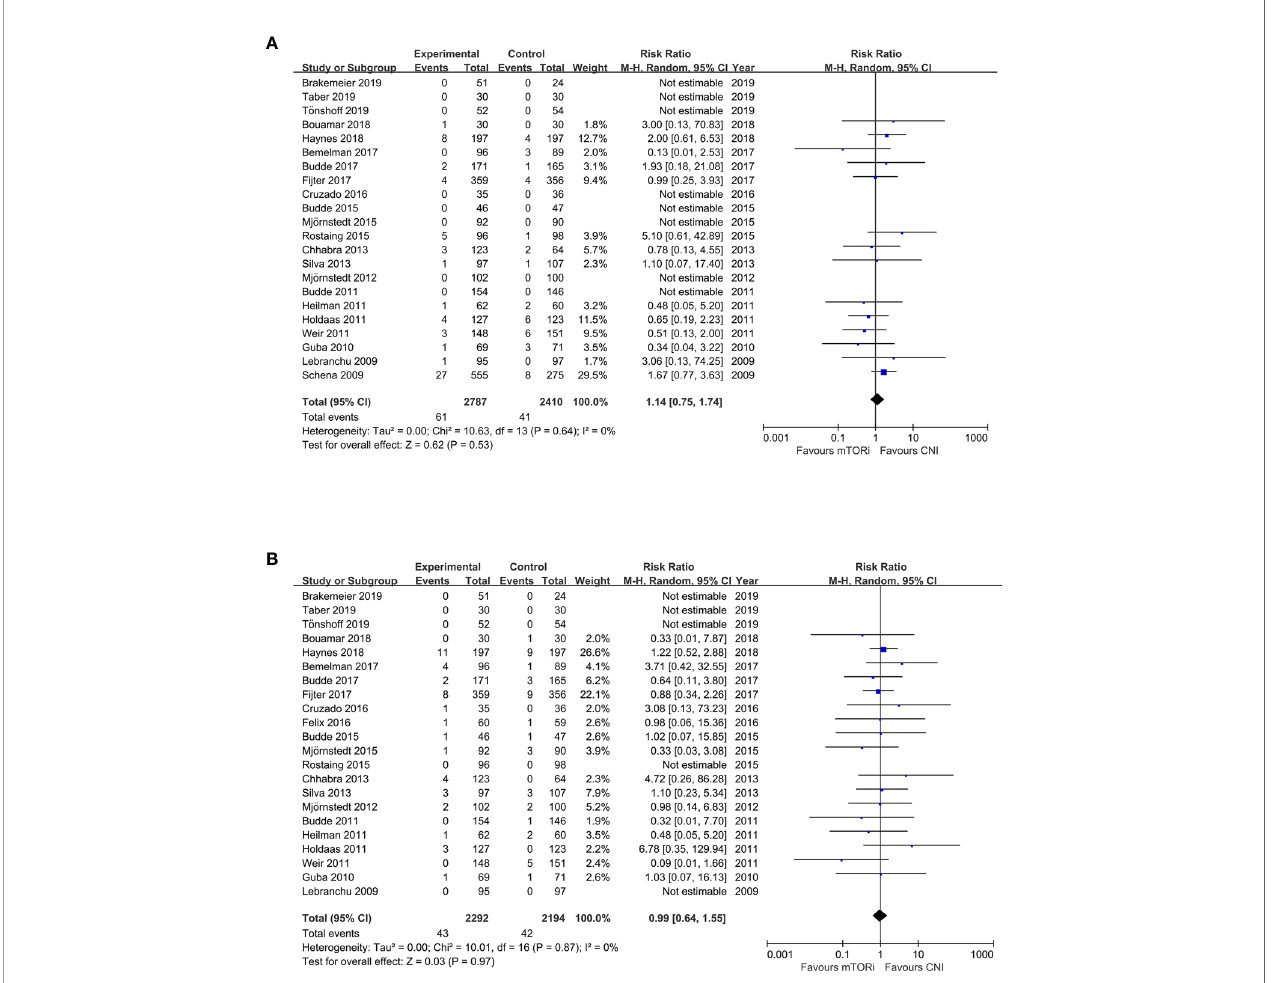
FIGURE 2 | The forest plot of studies that compared conversion from CNIs to mTOR inhibitors versus maintenance of CNI therapy for the outcomes of (A) renal function (eGFR) and (B) acute rejection